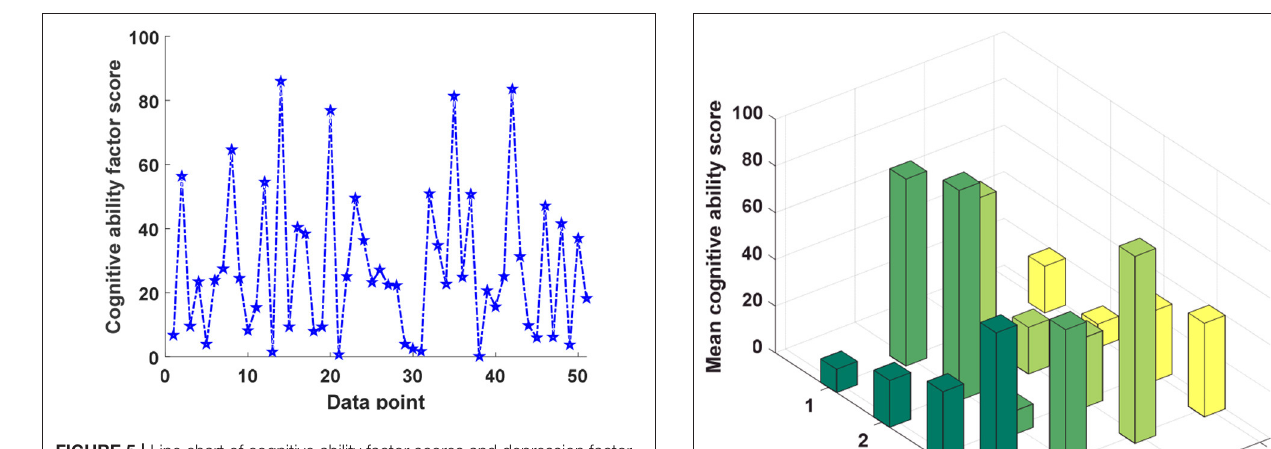
behind children are the highest, and non-left